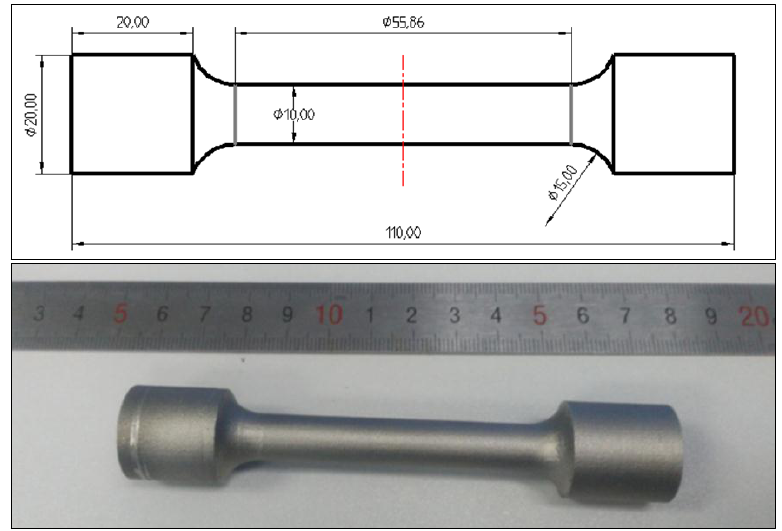
Figure 2. Dimensions of the tensile test sample.